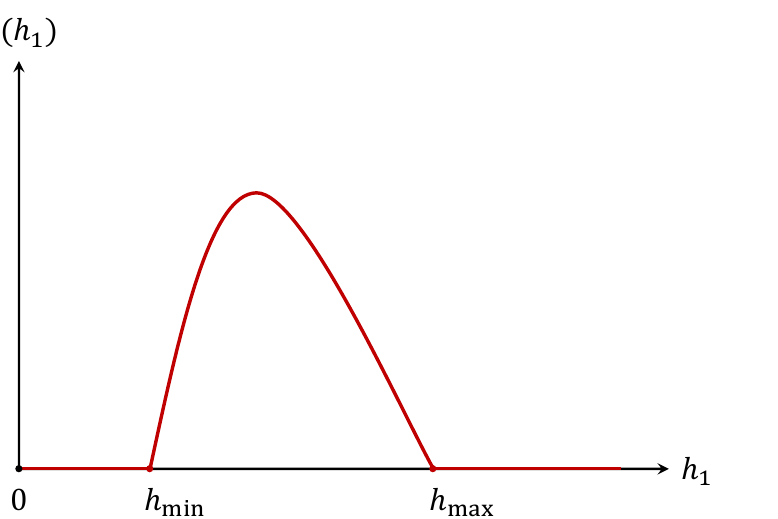
Figure 1. A sketch of a finite probability density function for sea-level rise satisfying the assumptions from Section 3.1.